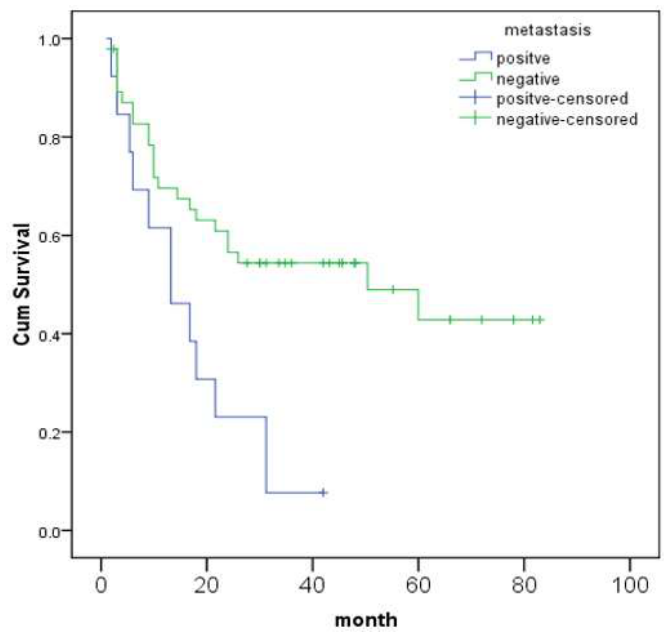
Figure 4 : The average survival of patients with and without metastasis. The average abundance of survival based on the treatment method has shown in table 3. Table 3 : Average abundance of survival based on treatment